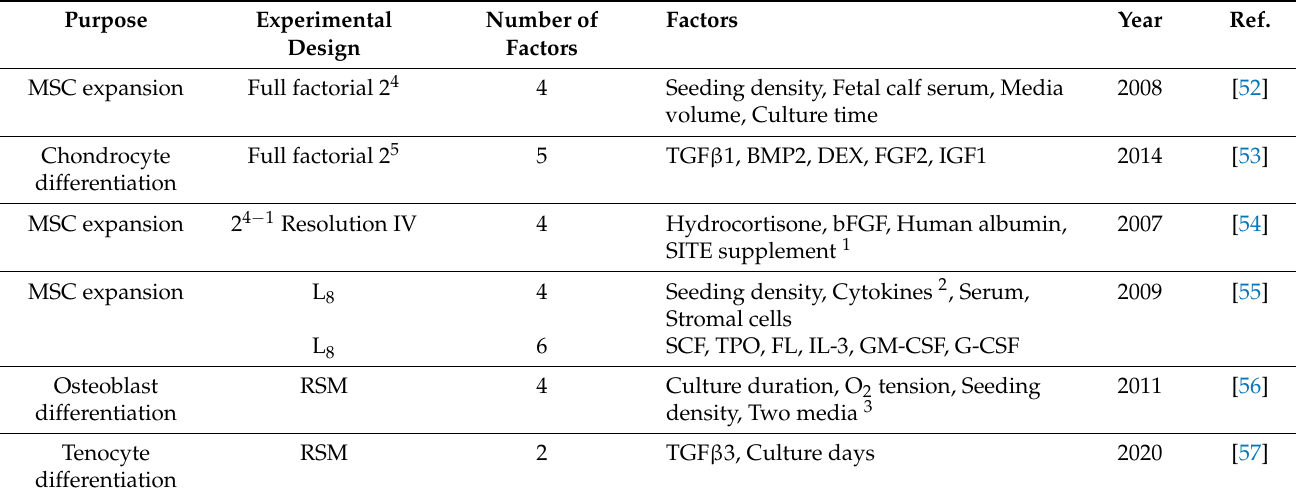
Table 3. DOE studies investigating MSC expansion and